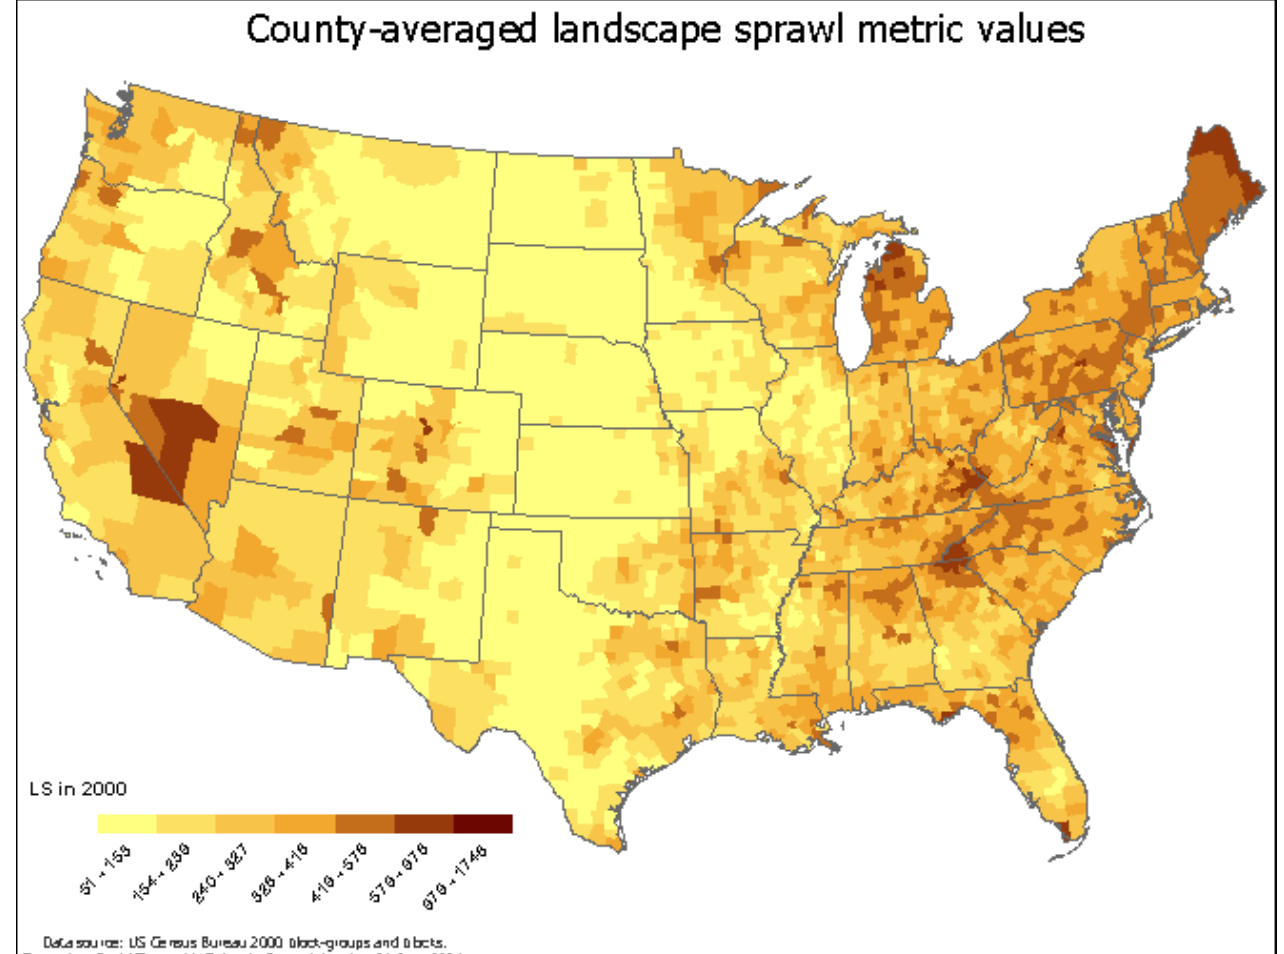
Fig. 15. Landscape sprawl metric values for the U.S. in 2000, averaged by county. Higher values indicate more sprawl or greater effect on the